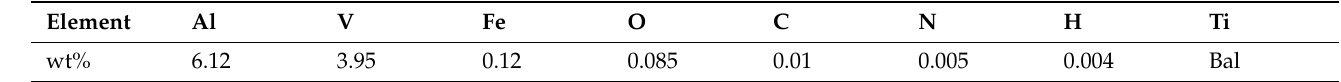
Table 1. Approximate chemical composition of titanium alloy TC4 (wt%).